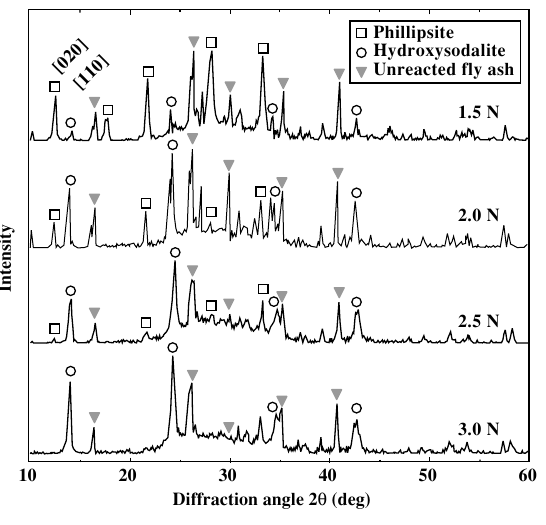
Fig. 3 XRD intensity and adsorption mass of NH 4 + for products as a function of NaOHaq.concentration (Treatment time =